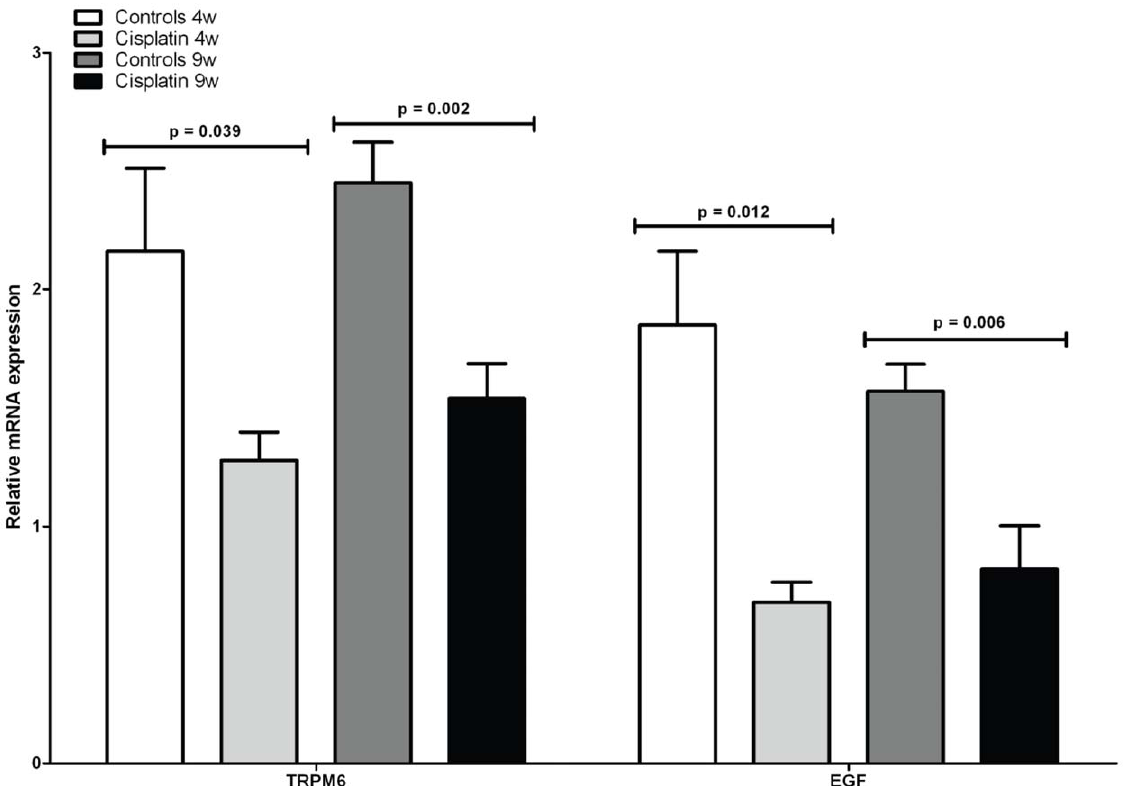
Figure 3. mRNA expression levels of TRPM6 and EGF. Effect of cisplatin on renal mRNA expression levels of Mg 2 + transport protein TRPM6 and EGF in the rat kidney. Data are presented as means 6 SD, each group containing n=6. Statistics were performed using generalized linear models.